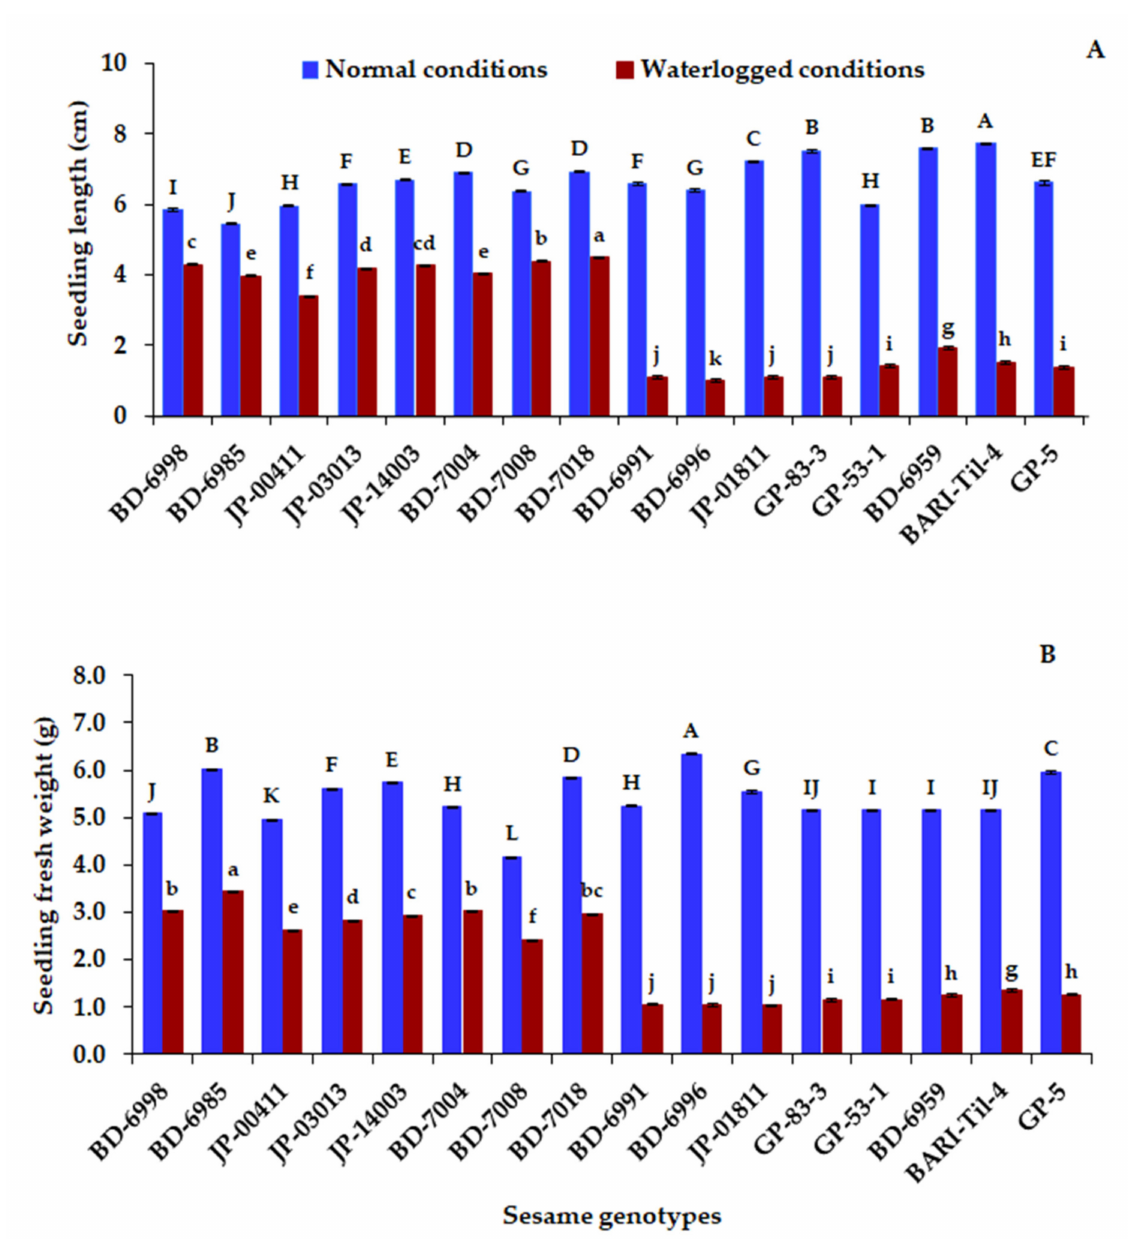
Figure 2. Seedling lengths ( A ) and fresh weights ( B ) of sixteen sesame genotypes under 48 h of waterlogging. Different uppercase letters indicate significant differences by LSD ( p < 0.01) under normal conditions, while lowercase letters indicate waterlogged